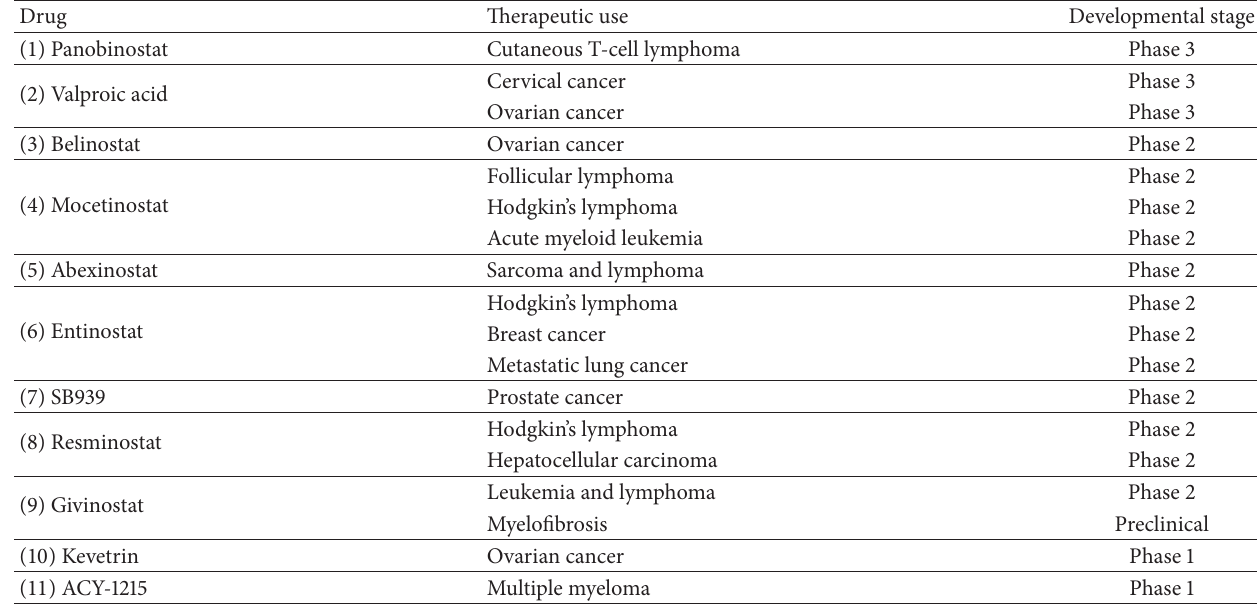
Table 2: HDAC inhibitors in developmental